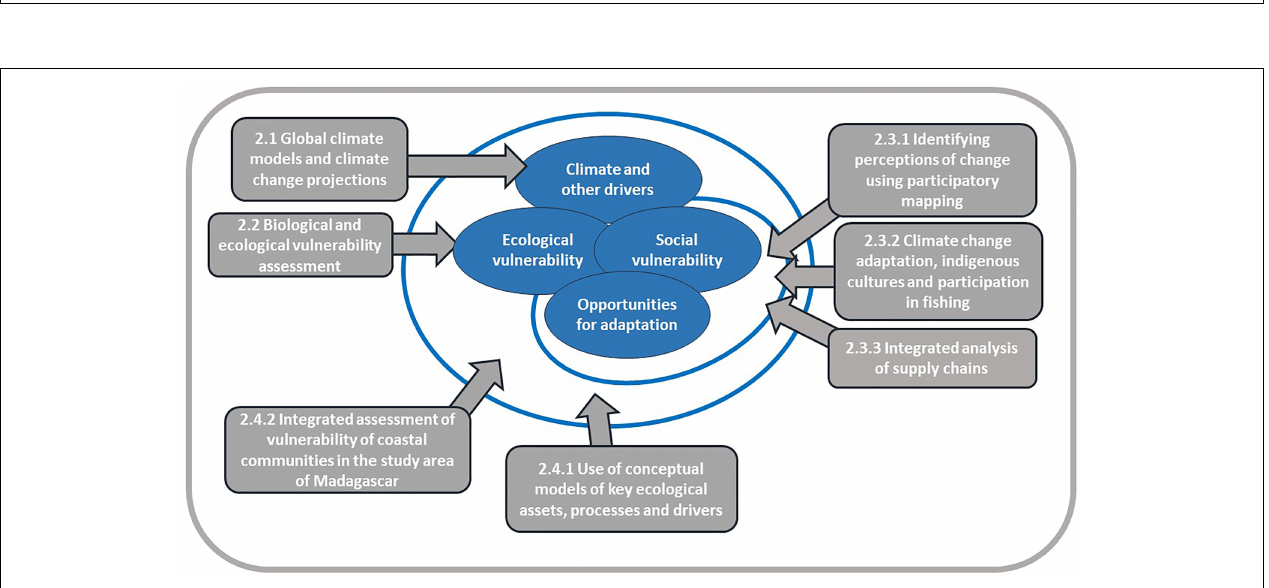
FIGURE 1 | Map of Madagascar showing the sites of two workshops and of Ambola and Ambotsibotsike, the two fishing communities that participated in the field surveys undertaken through the GLORIA project.